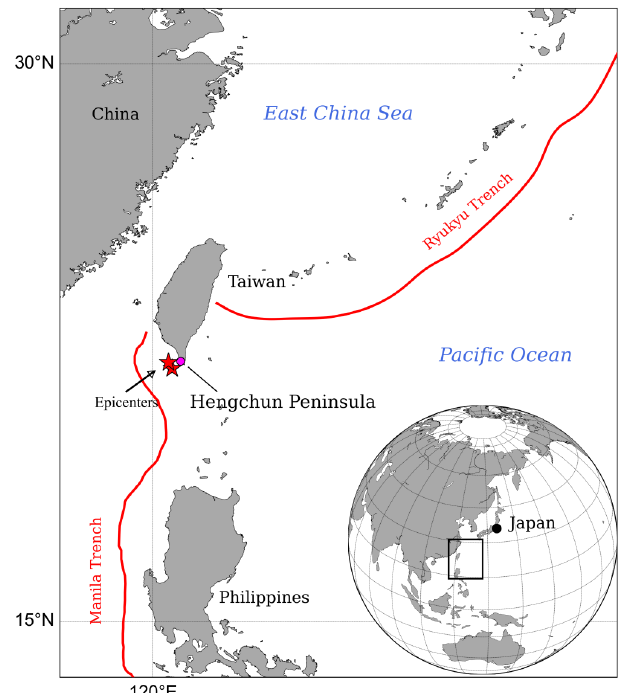
Figure 1. Map of the Hengchun Peninsula, Taiwan. The red stars illustrate the epicenters of the doublet earthquakes, and the solid red lines illustrate the subduction zones of the Manila Trench and the Ryukyu